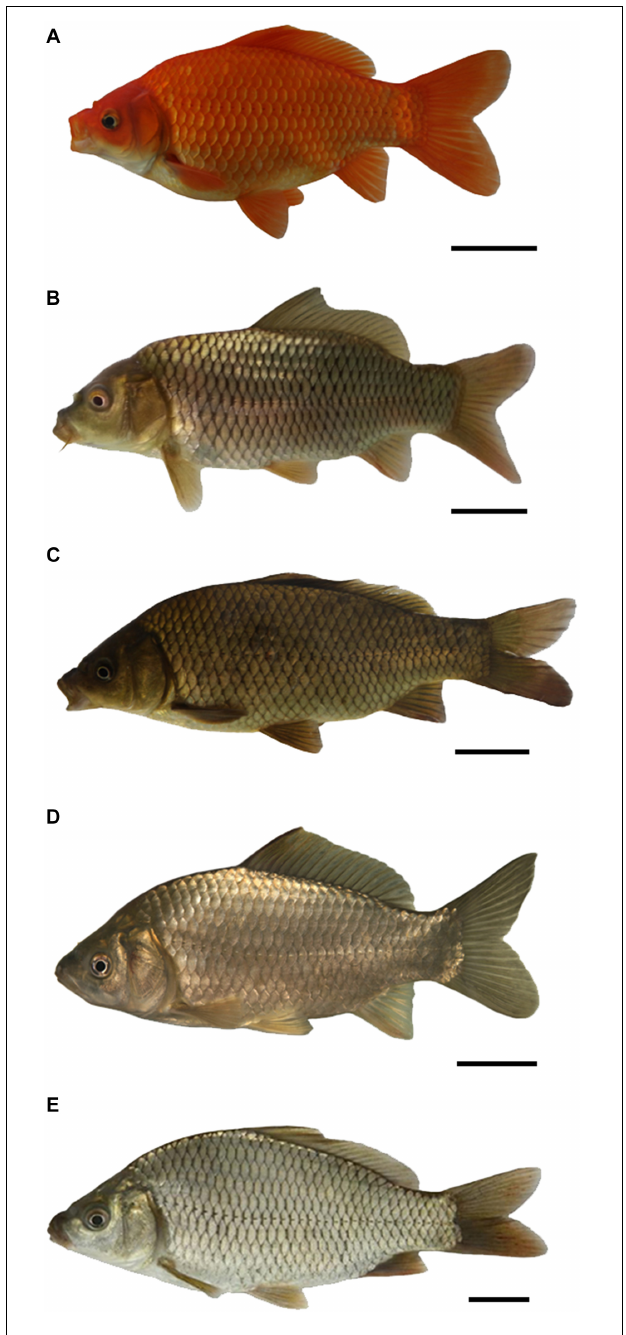
FIGURE 1 | Appearance of RCC, CC, 4nAUT, 3nAUT, and 3nALT. (A) RCC; (B) CC; (C) 4nAUT; (D) 3nAUT; (E) 3nALT. Bar = 5 cm.